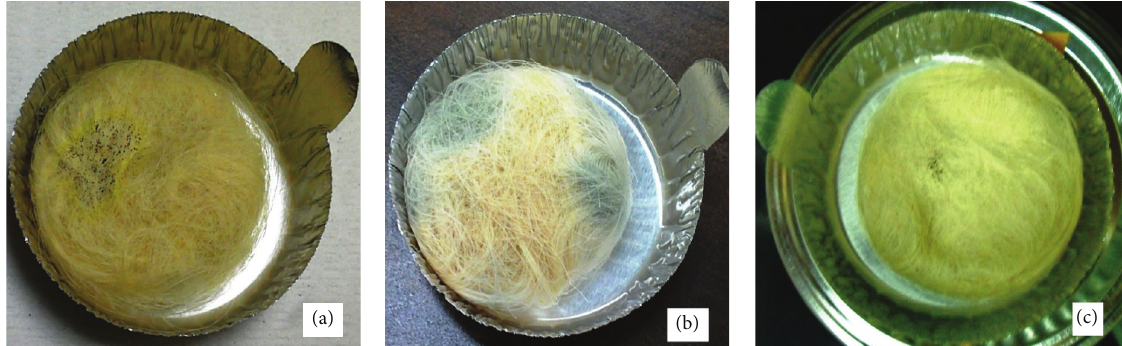
Figure 2: One gram of soy/PE fiber sample in aluminum pans that developed mold spoilage. (a) Mold spores, (b) visible mold mycelium when placed in high humidity environments, and (c) mold growth on fibers with an area approximately 5% of total area that was termed as positive mold spoilage for modeling